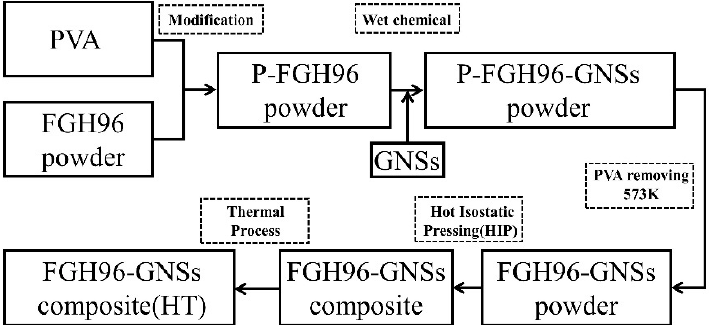
Figure 1. The flow diagram of the preparation process of the GNS reinforced PVA modified FGH96 composites.